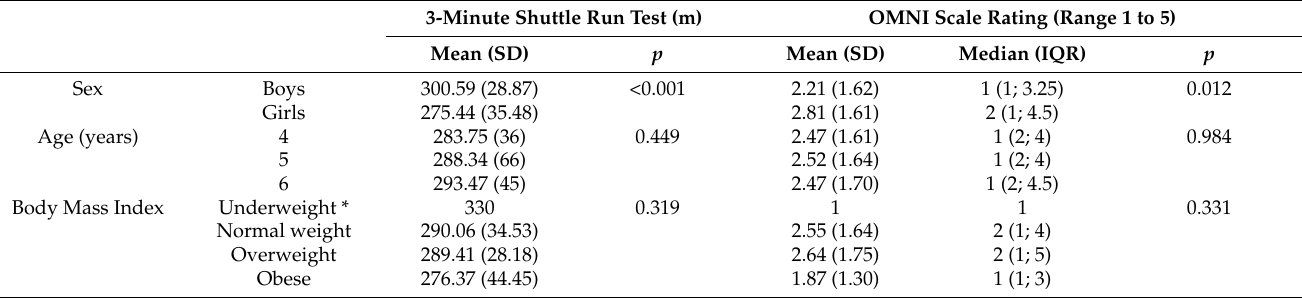
Table 2. Distance covered in the 3-minute shuttle run test and OMNI scale ratings across sex, age, and body mass index strata.